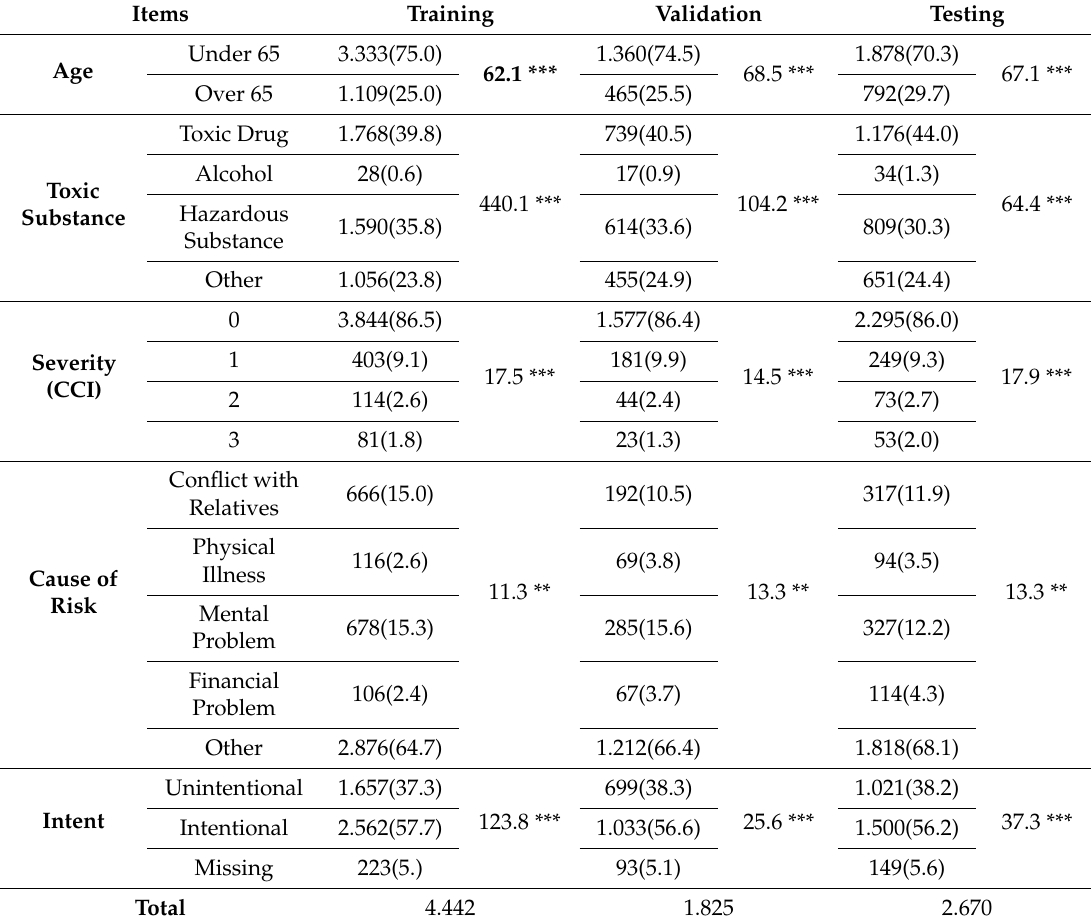
Table 1. Results of